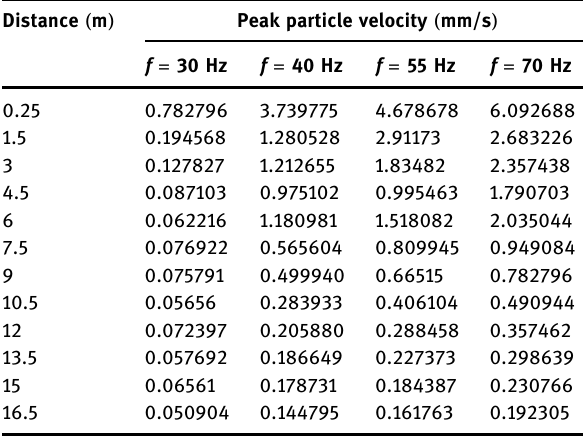
Table 4: The measured peak particle velocities at di ff erent locations for various frequencies ( no wave barrier